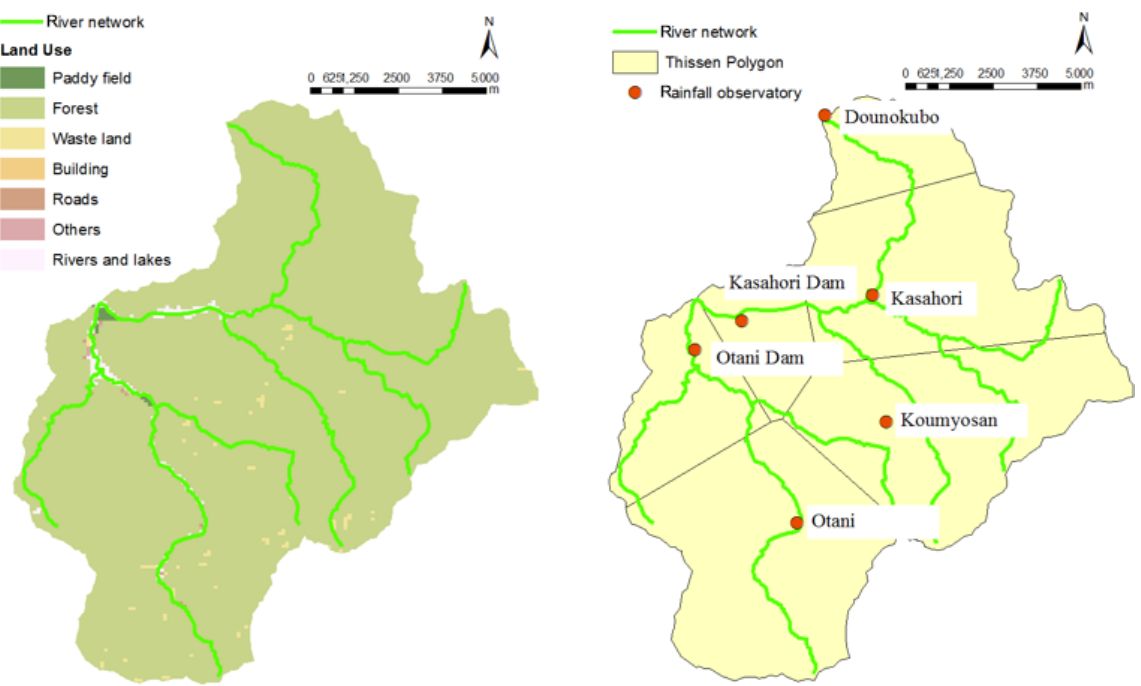
Figure 3. Land use of the Kasahori and Otani dam catchments (left). Rainfall observatories and Thiessen polygons of the Kasahori and Otani dam catchments